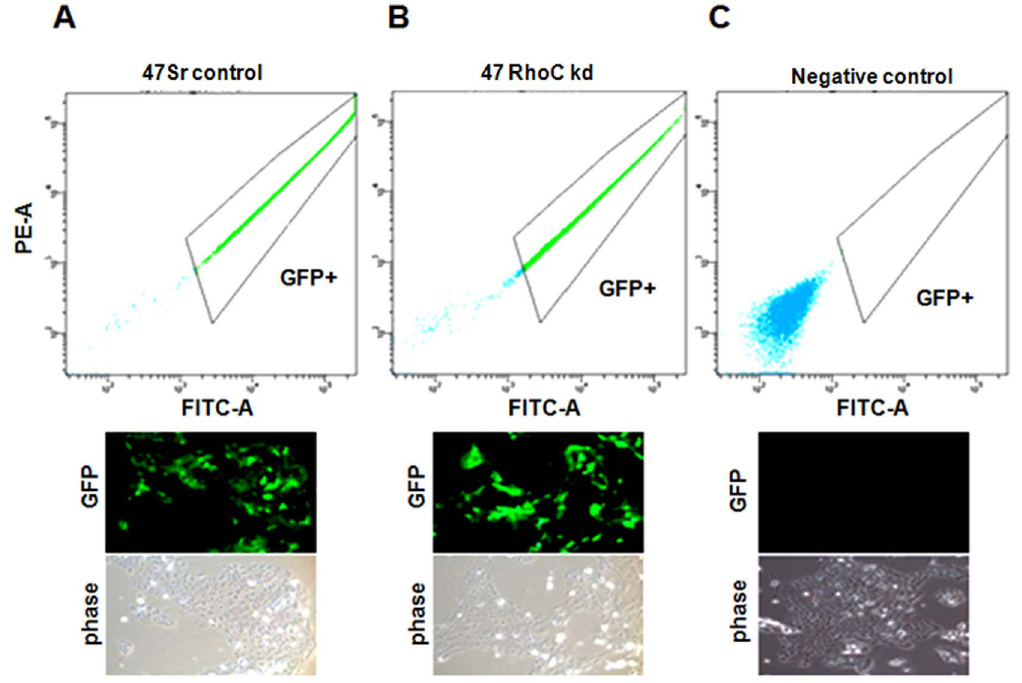
Figure 1. Lentivirus infection and transduction in UM-SCC- cell line. Lentivirus infected cells showing the GFP expression in UM-SCC-47. (A) Histograms of the scrambled control (sr control) and (B) RhoC knockdown (RhoC kd) obtained by flowcytometry. (C) Negative control. Representation of the GFP expression in fluorescence and bright light are shown in the bottom panels. About 90% of cells were GFP positive signifying the successful transduction of shRNA using recombinant lentivirus.